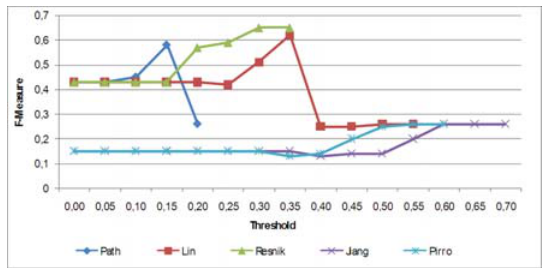
Fig. 3. The F-measure curves for the matching process with different Corresponding concept